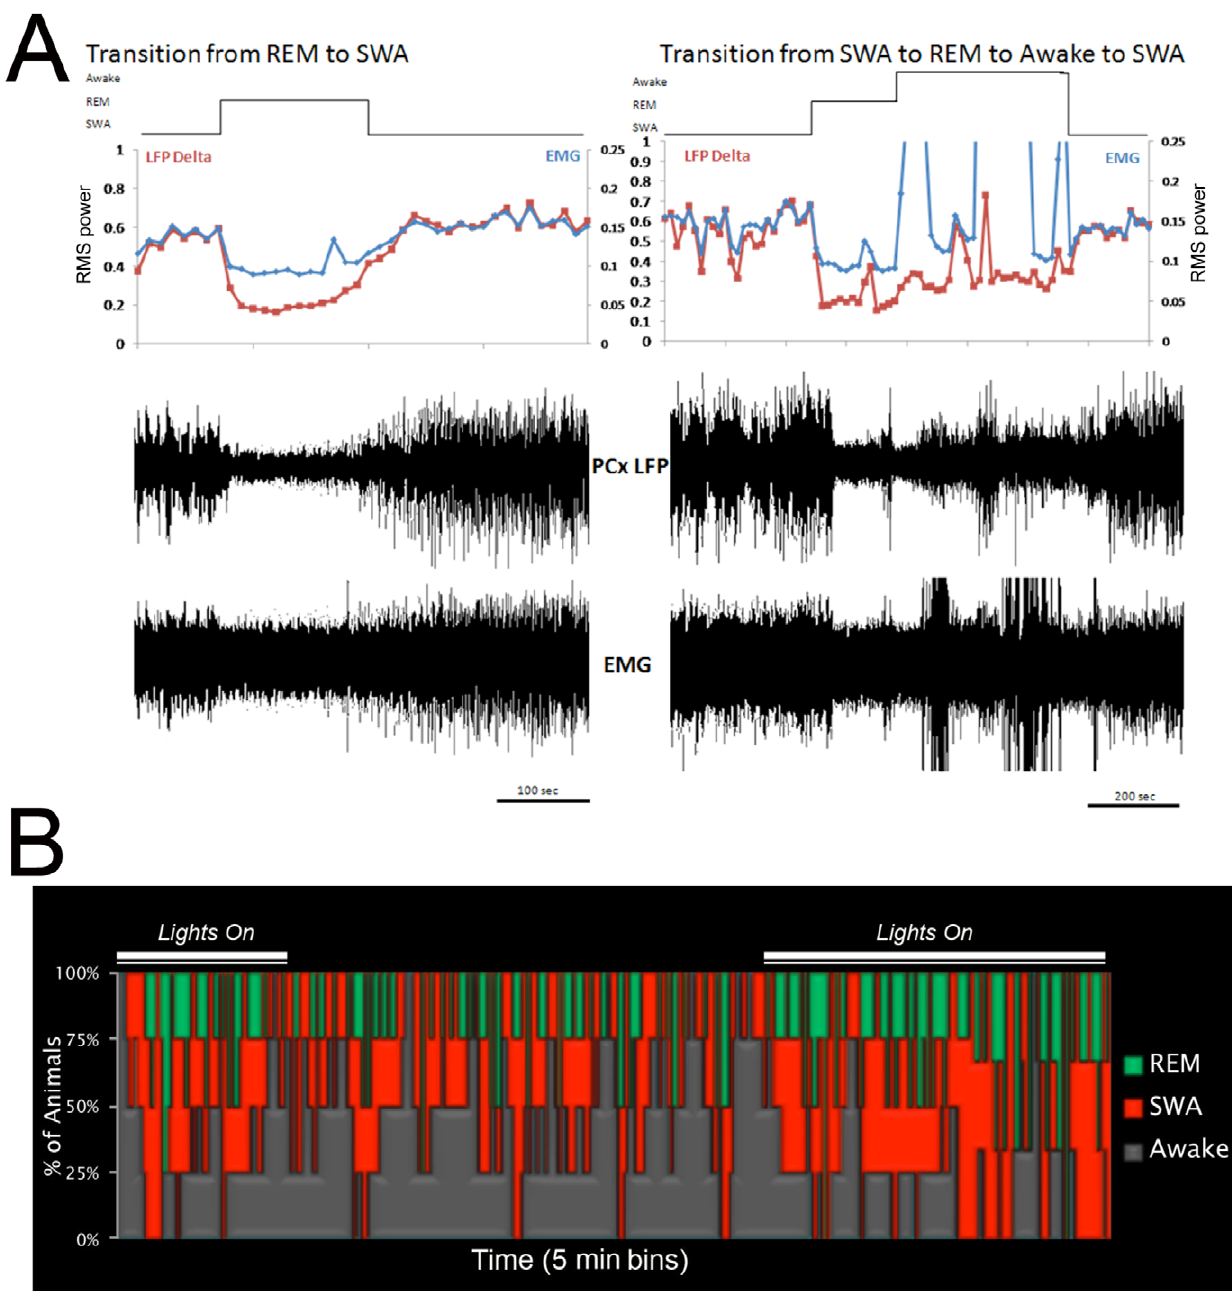
Figure 1. Representative data from one animal showing transition between behavioral states. ( A ) Left, a representative example showing a transition from SWS into REM sleep and returning to SWS as recorded in the anterior piriform cortex (PCX). Each point on the line graph represents a fourteen second time window. The waveforms below are raw LFP and EMG data showing the same window of time as the line graphs above. Note the change in both LFP and EMG frequencies when the animal enters REM sleep. Right, an example of the same animal transitioning from SWS to REM to Awake then returning to SWS. SWS is characterized by high delta power activity and relatively low EMG activity. REM is typified by low delta LFP activity and very low EMG activity. Awake state is distinguished by high frequency activity (lower delta) in the LFP and high frequency EMG waveforms. ( B ) A mean hypnogram recorded in the anterior piriform cortex of 4 naı¨ve rats placed individually in the recording chamber at 3 p.m. for 24